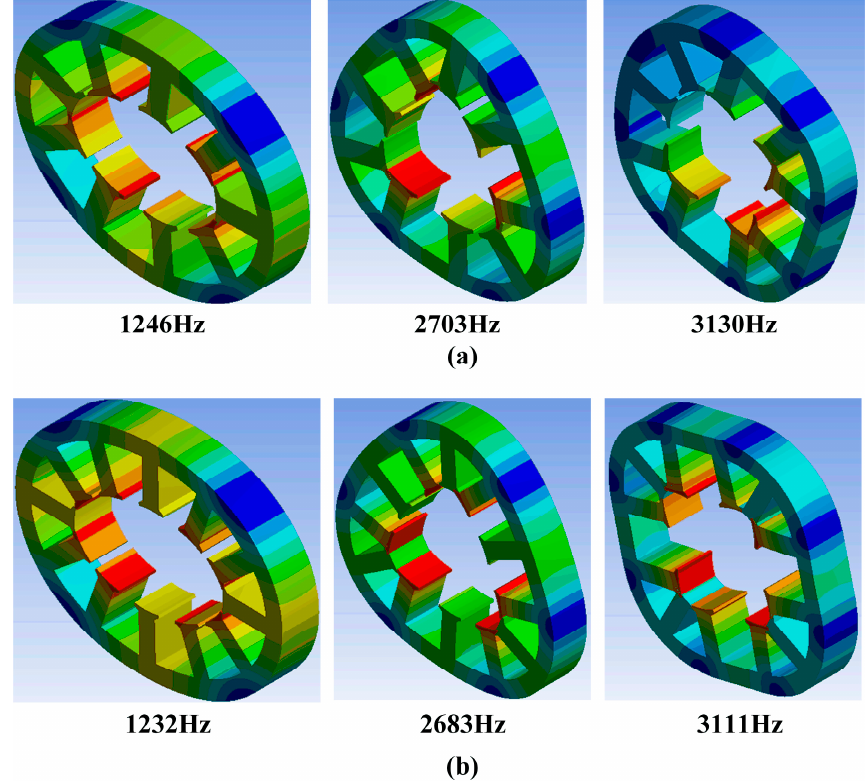
Figure 5. The modal analysis result of permanent magnet machines with two different pole/slot combinations: ( a ) 9-slot and ( b ) 12-slot. combinations: ( a ) 9-slot and ( b )